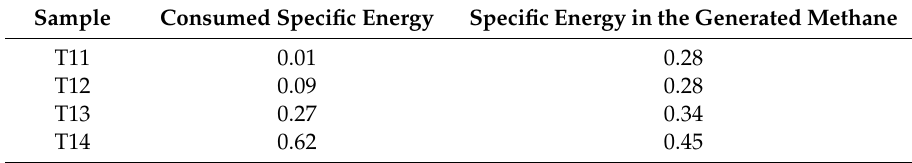
Table 3. Energy balance of the process: Consumed specific energy (electricity during the HC process) and specific energy available in the generated methane (chemical energy). Units are kWh/kg fresh weight.